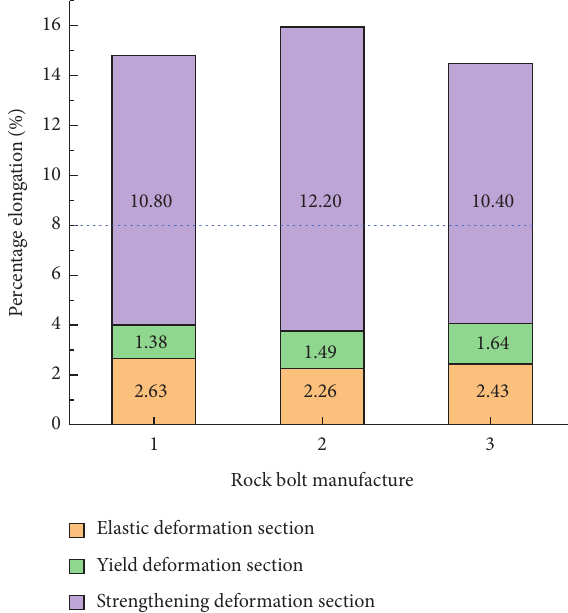
Figure 14: Tensile test of MSGLD-500/22 bolts produced by different manufacturers.